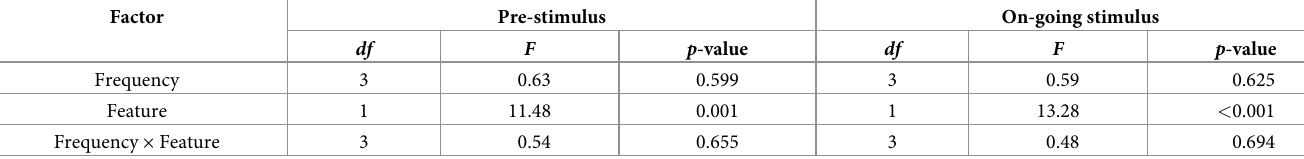
Table 3. Statistical results for classification performance.